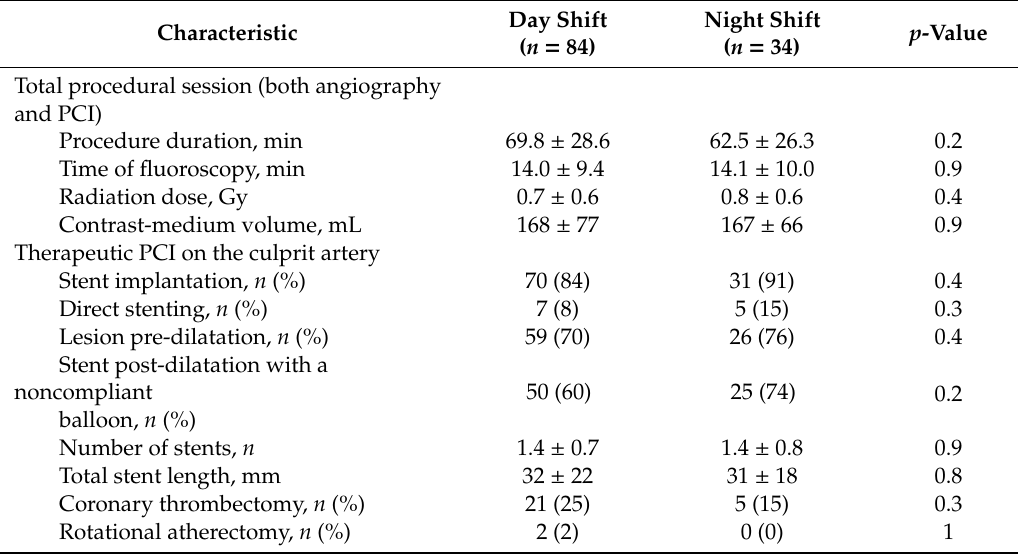
Table 2. Procedural characteristics of patients undergoing PCI for